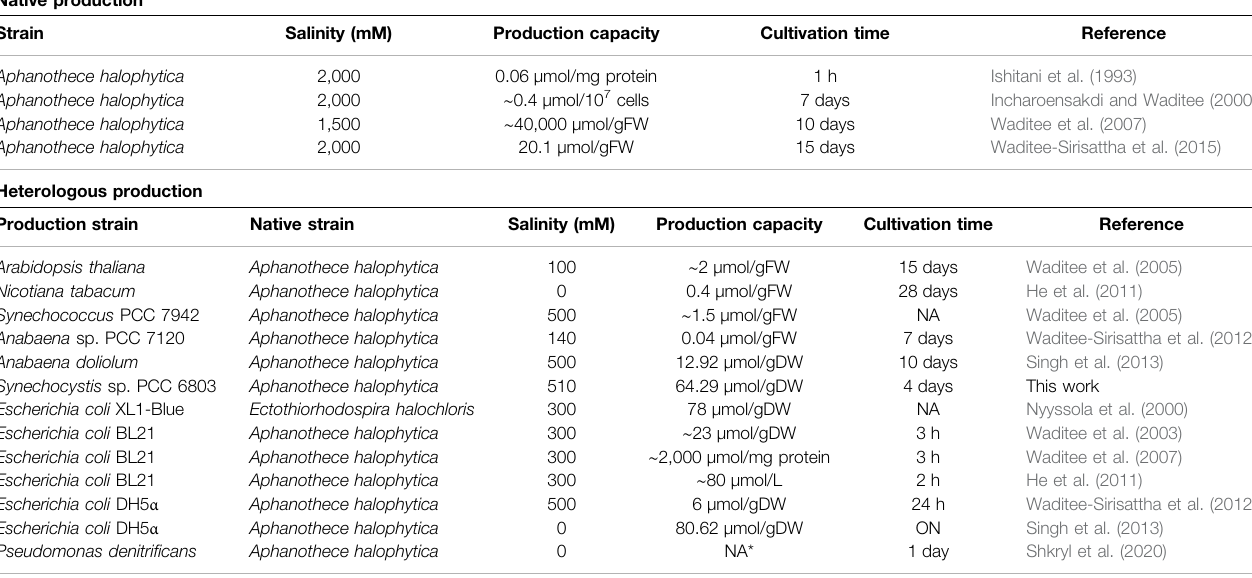
TABLE 2 | Native and heterologous production of glycine betaine via the three-step glycine methylation